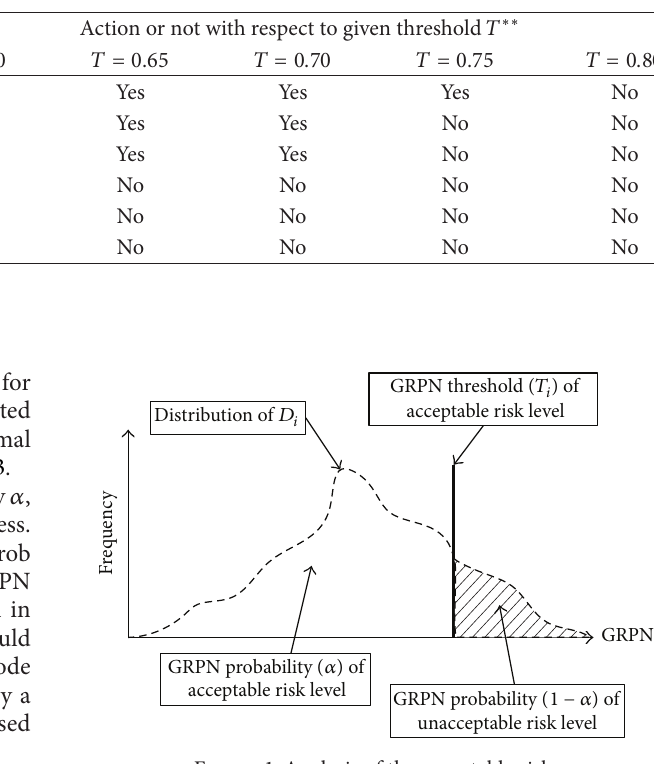
Figure 1: Analysis of the acceptable